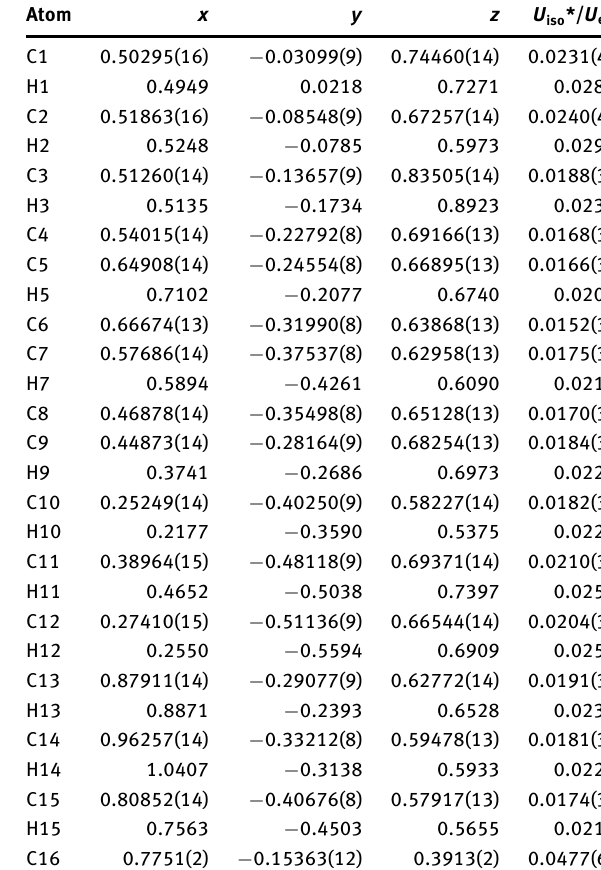
Table 2: Fractional atomic coordinates and isotropic or equivalent isotropic displacement parameters (Å 2